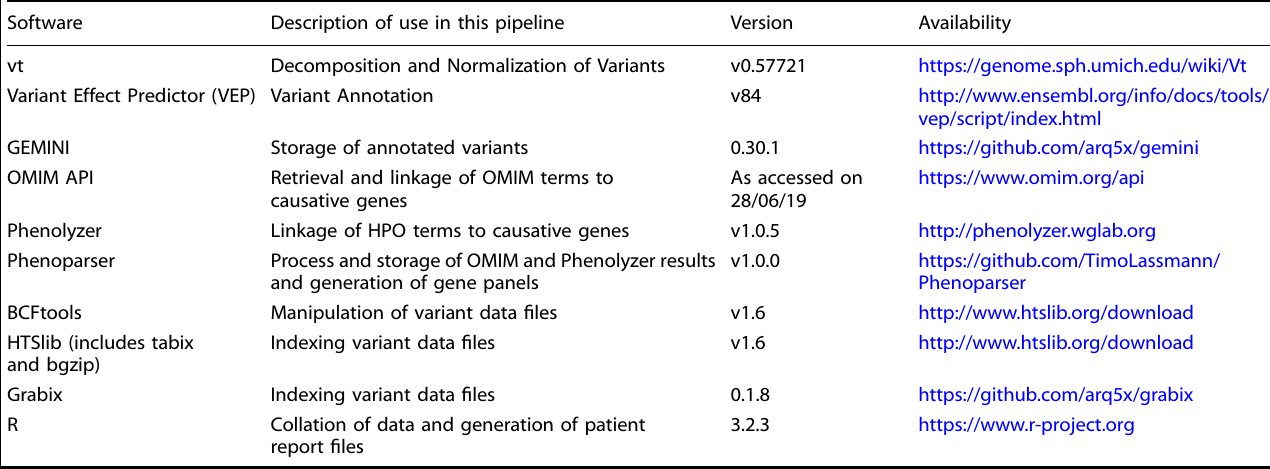
Table 5. Software components of the